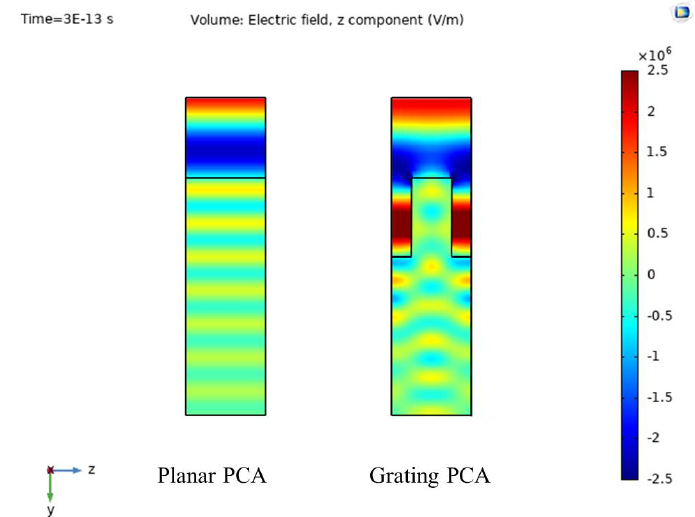
Figure 6. The z component of the electric field of a planar PCA and a grating PCA at a peak excitation time point, t = 300 fs. The geometrical parameters listed in Table 1 apply to both grating and planar PCAs, except F = 1, which is used for the planar PCA.